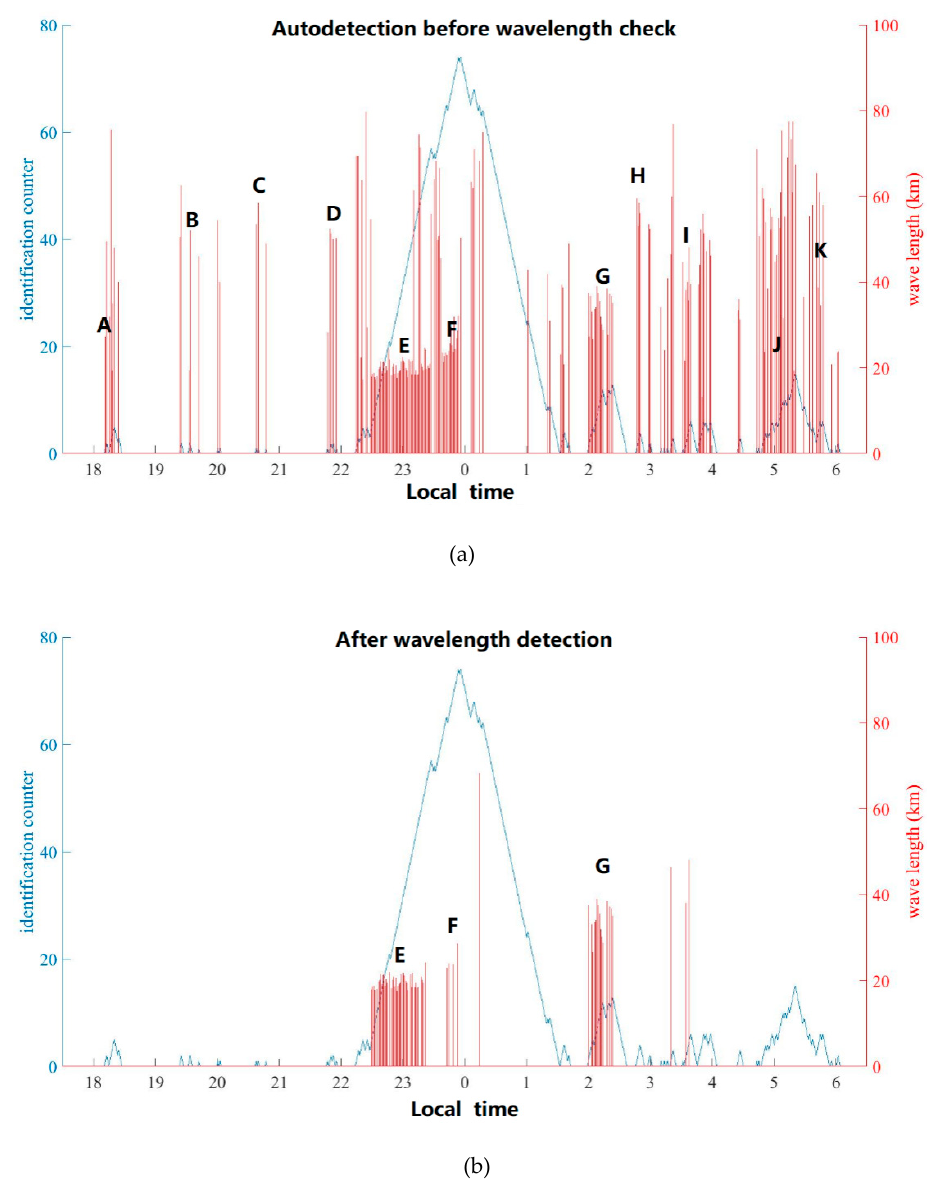
Figure 10. Wave detection results on 27 January 2014 ( a ) before and ( b ) after the wavelength-change check. The x-axis is the local time. The left y-axis is the identification counter used to calculate the number of consecutive images containing wave structures. The blue curve shows the change in the counter and a rising slope indicates a series of wave-containing images in a row. For each series of wave-containing images, an image is sampled and presented in Figure 11 with the same label. The right y-axis is the wavelength. The red bars show the wavelengths of the extracted wave patterns.